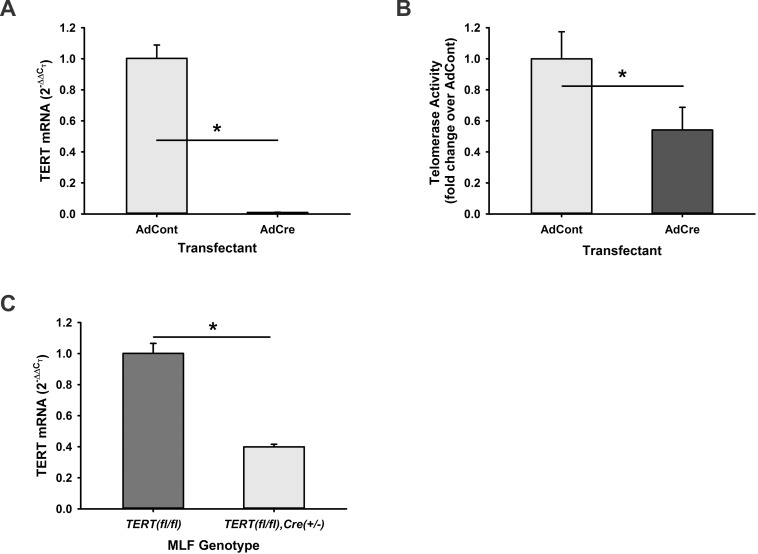
The in vitro excision of MLF TERT by Cre activation.The MLF were isolated from TERT fl/fl mice, and then transduced with 100 MOI of AdCre vector or AdGFP control vector. Six days after transduction, TERT mRNA (A) and telomerase (B) were analyzed, respectively, as described in the legend of Fig 2. n = 3. (C) The MLF from TERT fl/fl or TERT fl/fl/,Cre+/- mice were treated with 5 μM of 4-OHT in vitro at the same time for 6 days, and TERT mRNA was analyzed. n = 3. *, P < 0.05.